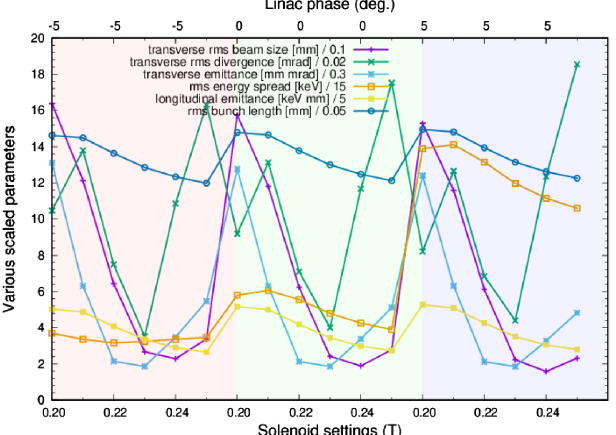
FIG. 10. Multiparameter plot at the exit of the linac comparing various transverse and longitudinal beam parameters as a function of both gun solenoid settings and linac phases. The block color coding indicates scans at a constant linac phase but varying gun solenoid strength. At all solenoid settings, the bucking solenoid is set to cancel the magnetic field at the cathode.